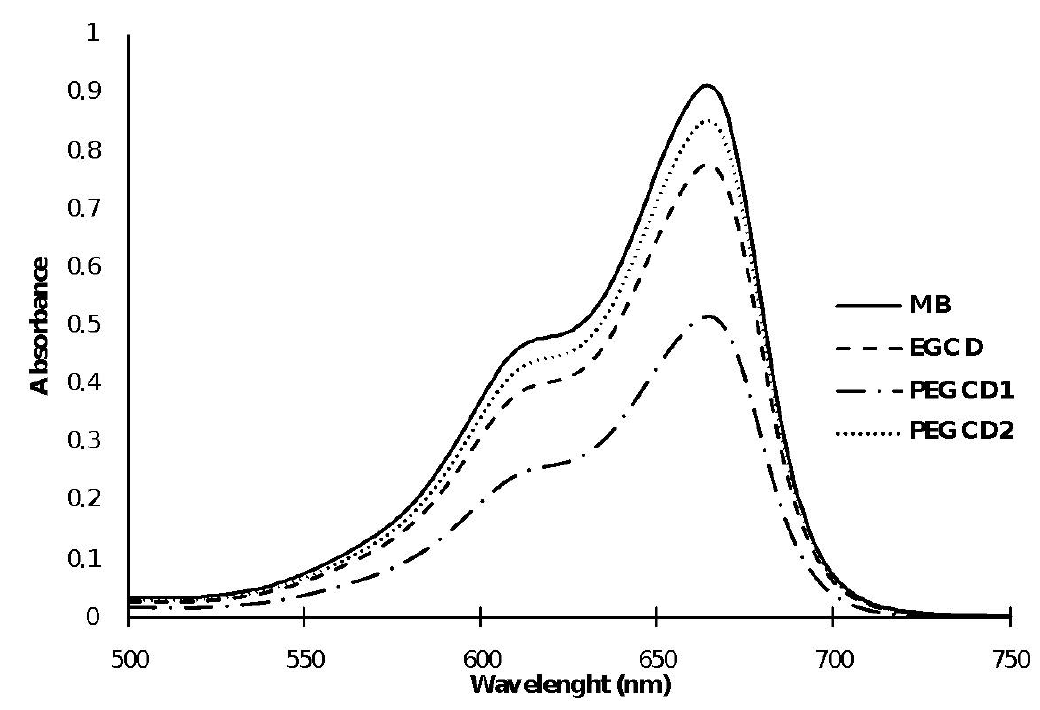
Figure 5. UV–vis spectra of the supernatant solution after sorption on the polymer compared to the initial solution of methylene blue (MB).